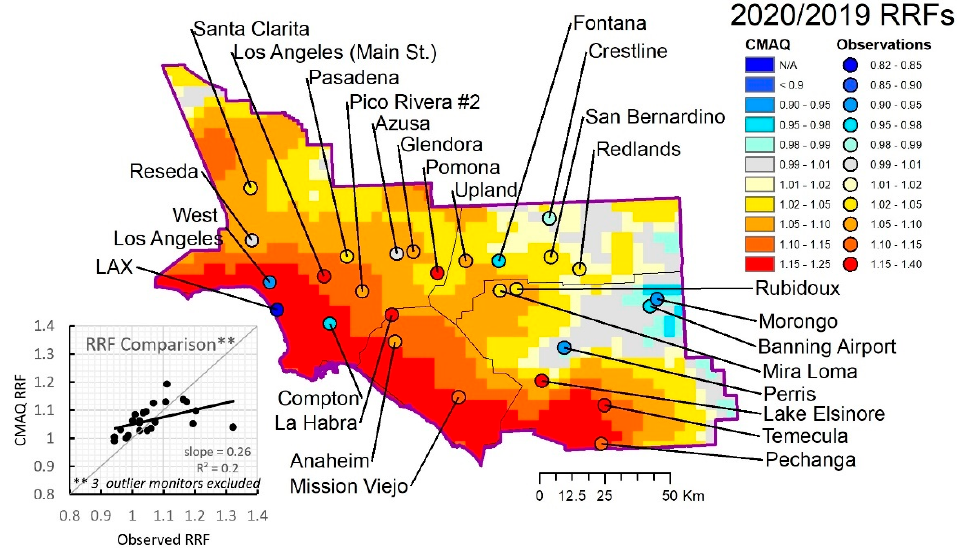
Figure 8. Comparison of CMAQ versus observed RRFs based on T10 modeled MDA8 ozone days.